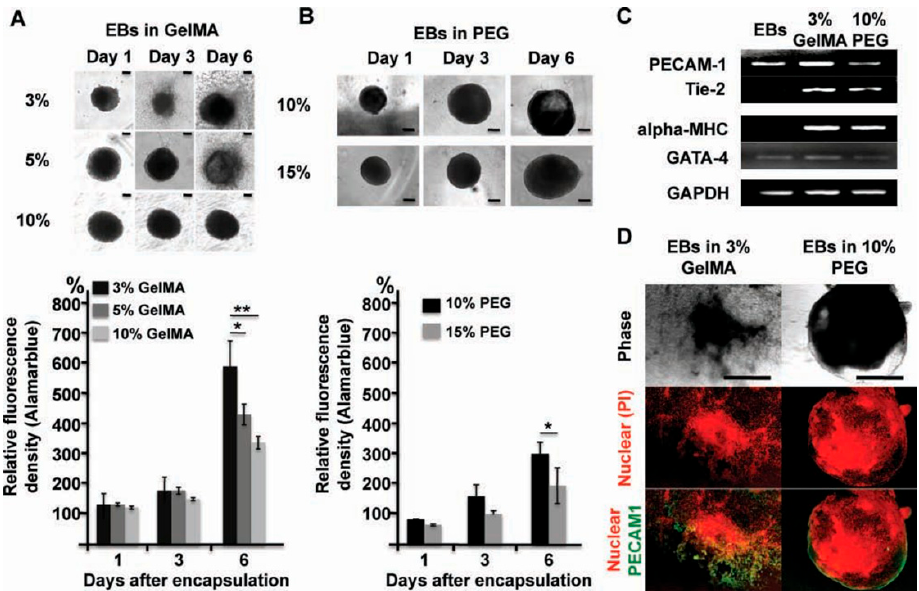
Figure 1. The effect of hydrogel properties on differentiation of EBs. ( A , B ) Phase contrast images of EBs. And cell proliferation was measured by using Alamarblue assay at same time point. ( C ) Expression of vasculogenic (PECAM1, Tie2) and cardiogenic (alpha-MHC and Gata4) in EBs after 6 days, and in EBs before encapsulation (left line). ( D ) Immunostaining PECAM1 (green) (scanning confocal microscopy) in EBs encapsulated in 3 wt % GelMA ( left lane) and 10 wt % PEG ( right lane) after 7 days culture with nuclear co-staining (PI, red) [40]. (Reproduced with permission from Qi H et al. Adv Mater; published by John Wiley and Sons,